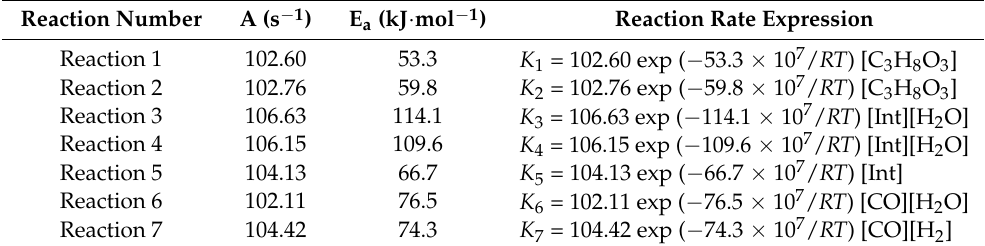
Table 1. Kinetic parameters for supercritical water gasification of glycerol. Reaction